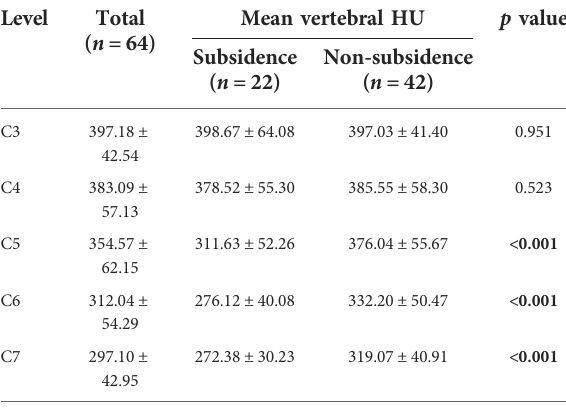
TABLE 3 Mean HU values of different subaxial cervical vertebrae in patients.